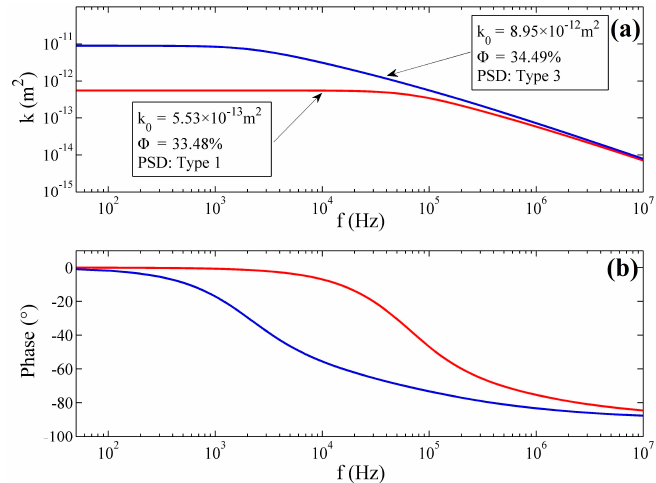
Figure 6. Frequency characteristic of the permeability. ( a ) Magnitude-frequency characteristic (MFC); ( b ) phase-frequency characteristic (PFC).